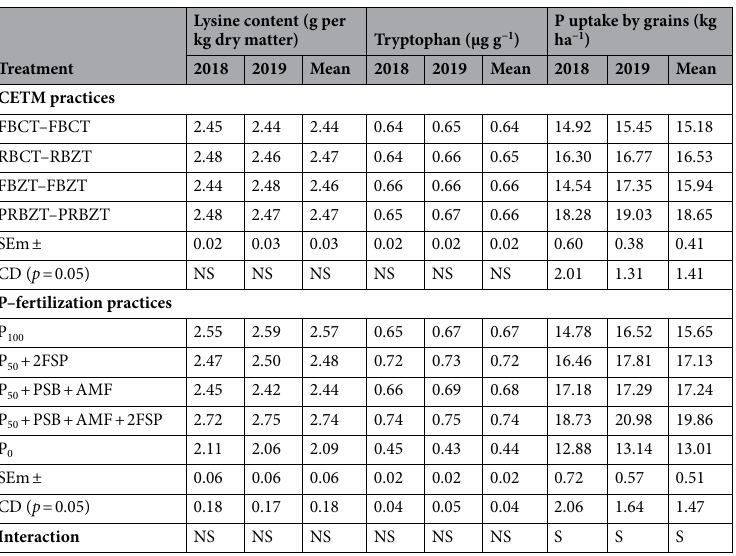
Table 2. Influence of CETM and P-fertilization practices on lysine (g per kg dry matter), tryptophan content (µg g −1 ) and grain-P uptake (kg ha −1 ) of maize under MWCS. CD values indicate the critical difference at p = 0.05.